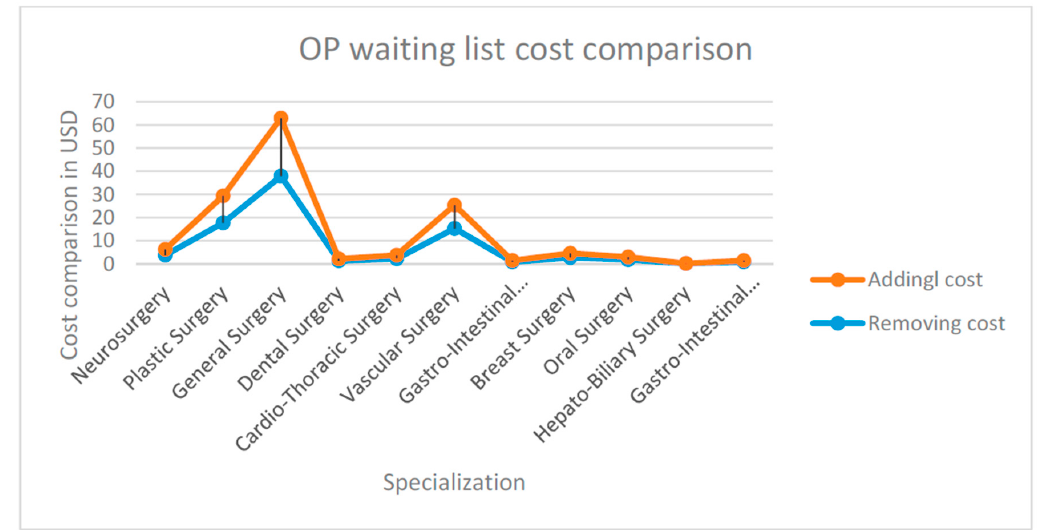
Figure 19. Smart contract deployment cost for Inpatients and Day cases (surgery) across different departments/specialty.